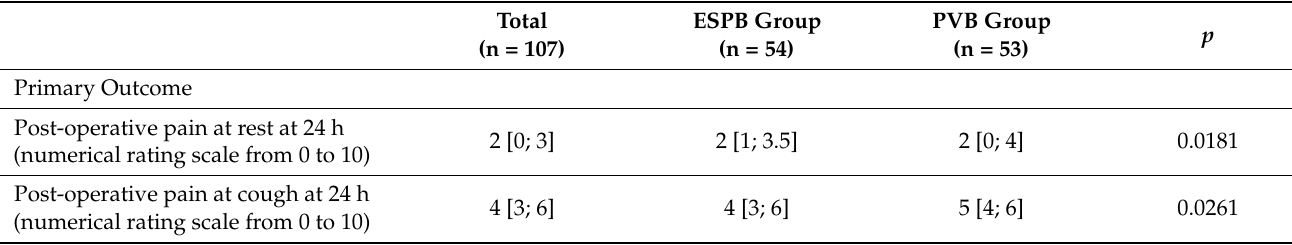
Table 1. Post-operative pain at rest and cough at 24 h.